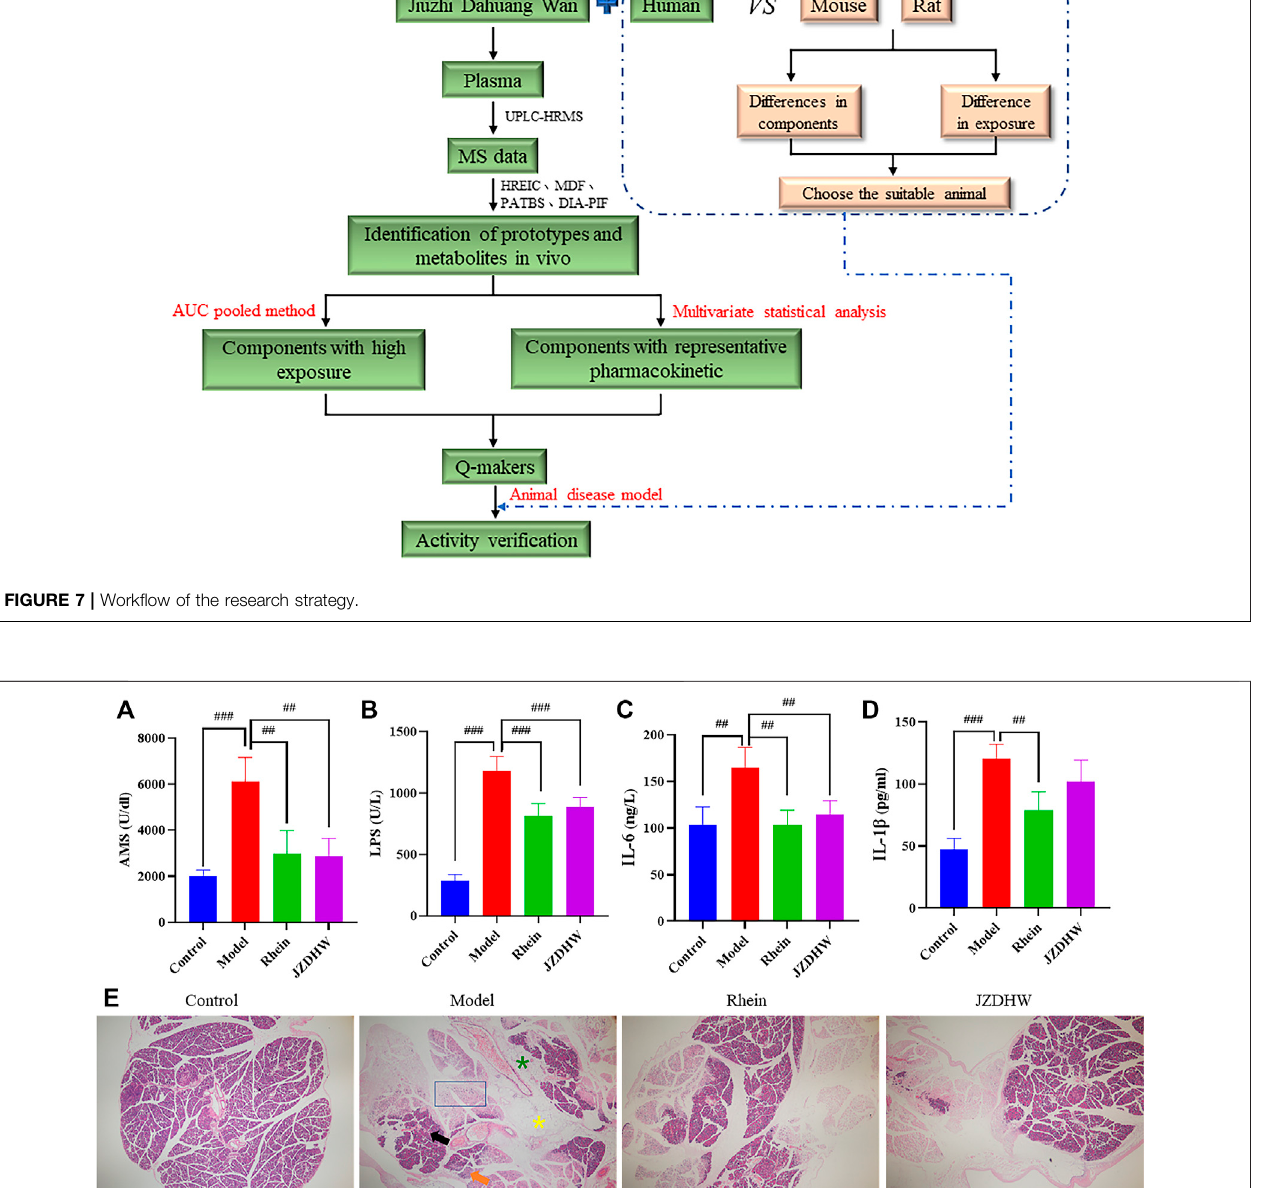
Frontiers in Pharmacology |